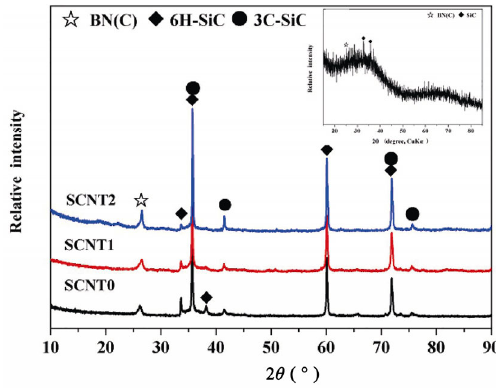
Fig. 4 XRD patterns of Si 2 BC 3 N ceramics with different content of SiC coated MWCNTs.